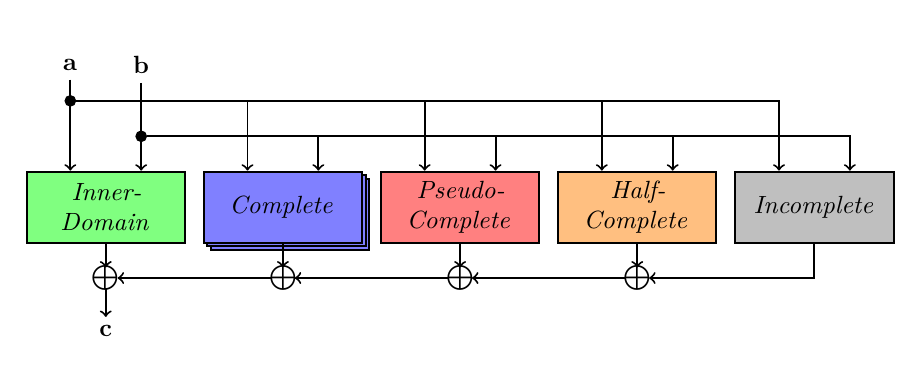
Figure 3: Connection of the UMA blocks [GM17].